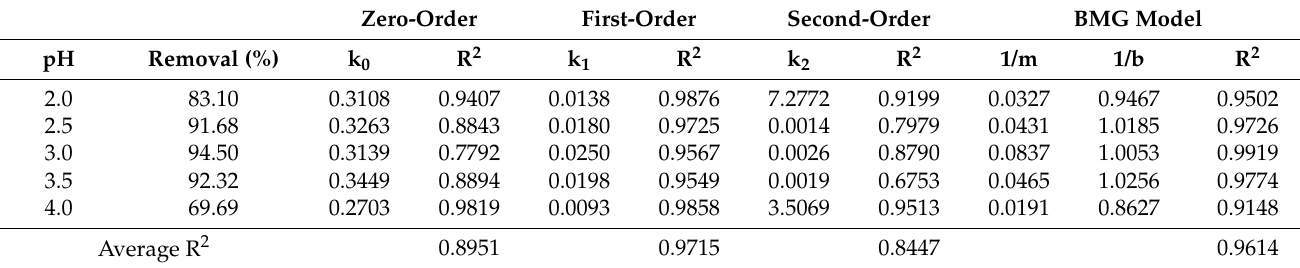
Figure 6. Degradation data of glyphosate using different kinetic models under different pH. Reaction system: initial CaO 2 dosage = 0.5 g, the molar ratio of Ca 2+ :Fe 2 + = 6, 100 mL 50 ppm glyphosate solution, 150 rpm, RT = 25 ℃ , contact time = 120 min. Table 3. Comparison of kinetic models at different pH. Zero-Order